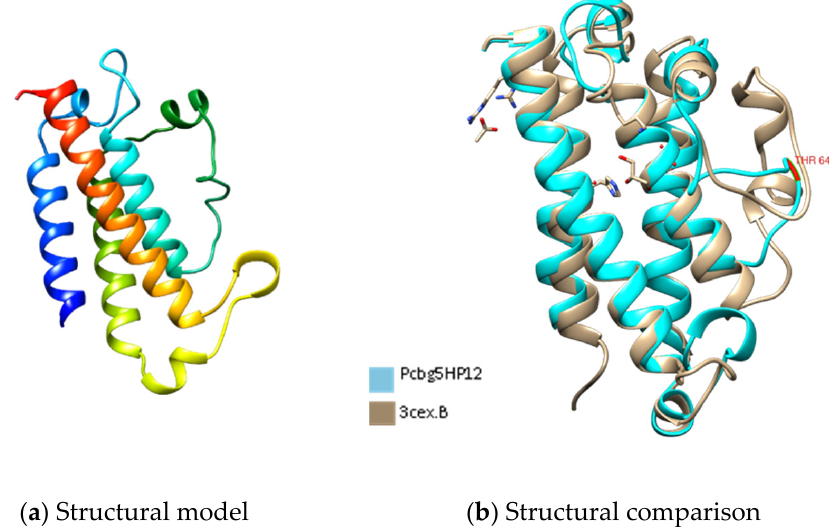
Figure 3. The three-dimensional structure analysis of PCBG5HP12. ( a ) The structural model of PCBG5HP12 was constructed using the Phyre2 server with 14% sequence identity to the structures of 3CEX as templates [45]. Image coloured by rainbow N → C terminus. ( b ) Comparative structural analysis between PCBG5HP1 model and Enterococcus faecalis uncharacterized protein (PDB 1PL8). Interestingly, the constructed model of PCBG5HP1 was predicted with a single disulphide linkage between Cys-95 and Cys-103 residues (Figure 4a), often an indicator of structural rigidity that is generally absent in psychrophilic proteins [42]. Despite this, the distance of the disulphide linkages in PCBG5HP1 was much longer, indicating a weaker interaction than that observed in the Neurospora crassa oxidoreductase (PDB 3M6I) homolog (Figure 4b).